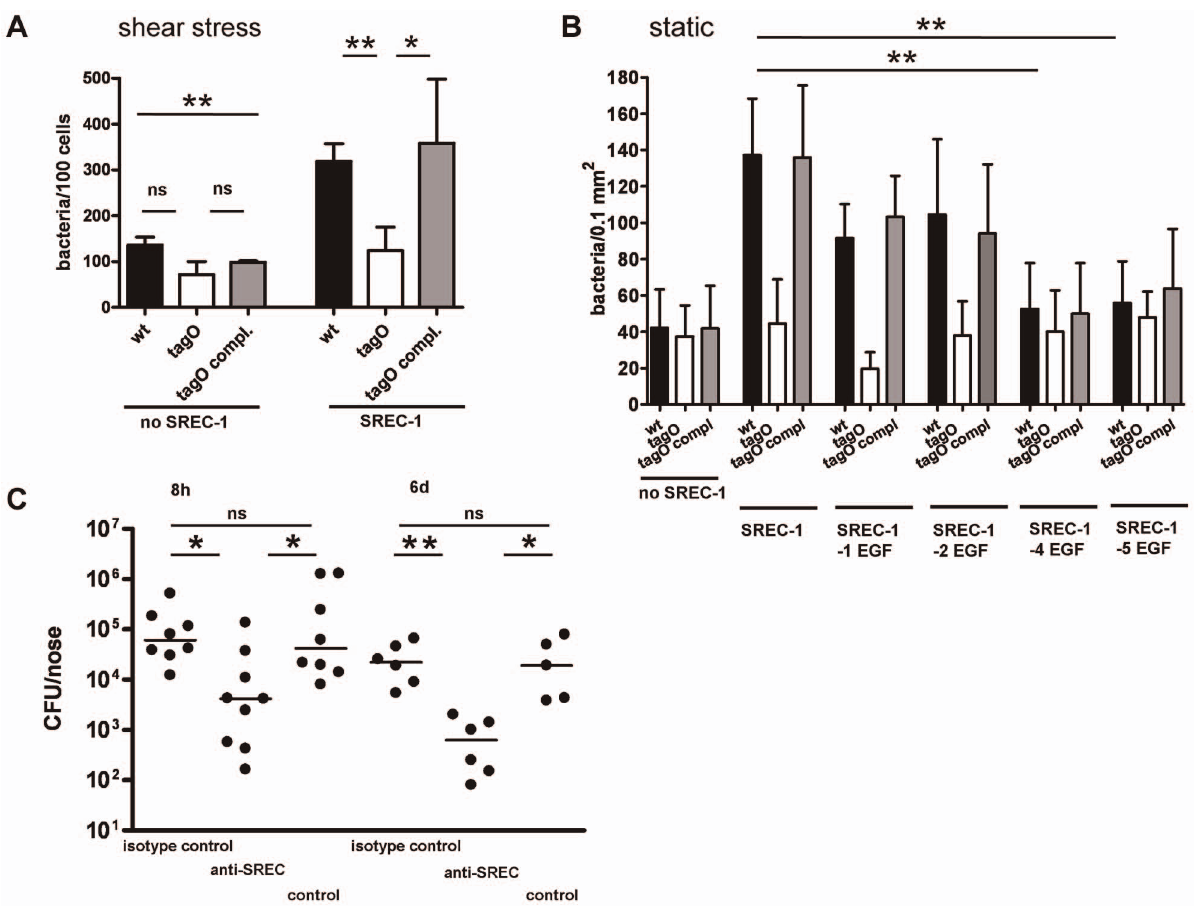
Figure 6. Impact of SREC-I on adhesion of S.aureus to CHO epithelial cells and impact of SREC-I on the early phases of nasal colonization in the cotton rat model. S. aureus adhesion to the cell line CHO expressing or not expressing SREC-I assayed in chamber slides under shear stress (A) and under static conditions (B). Attachment of S. aureus wt, tagO , and tagO compl. evaluated microscopically by counting at least 8 visible fields per well or chamber slide containing CHO cells without SREC-I or expressing full length SREC-I (A) or consecutive truncations of the extracellular EGF-like domains (B). Means and SD of 4 independent experiments (static) or 3 independent experiments (flow) are shown. Statistical analysis was performed by one-way ANOVA with Bonferroni’s multiple comparison test (A and B). Significant differences are indicated by one ( P , 0.05), two ( P , 0.01), or three ( P , 0.001) asterisks ( * ). Nasal colonization was assayed in a cotton rat model (C). Bacterial numbers were determined 8 h and 6 days after inoculation. 15 min prior to inoculation cotton rats were pretreated with 2 m g anti-SREC-I Fab 2 -fragment per nose. After 8 h and 6 days the noses were dissected and the bacterial CFU was evaluated on S. aureus selective highchrome agar. Statistical analysis was performed by D’Agostino & Pearson omnibus normality test and a subsequent Kruskal-Wallis non-parametric ANOVA with Dunn’s Multiple Comparison Test (C). Significant differences between groups are indicated by one ( P , 0.05), two ( P , 0.01), or three ( P , 0.001) asterisks ( * ).